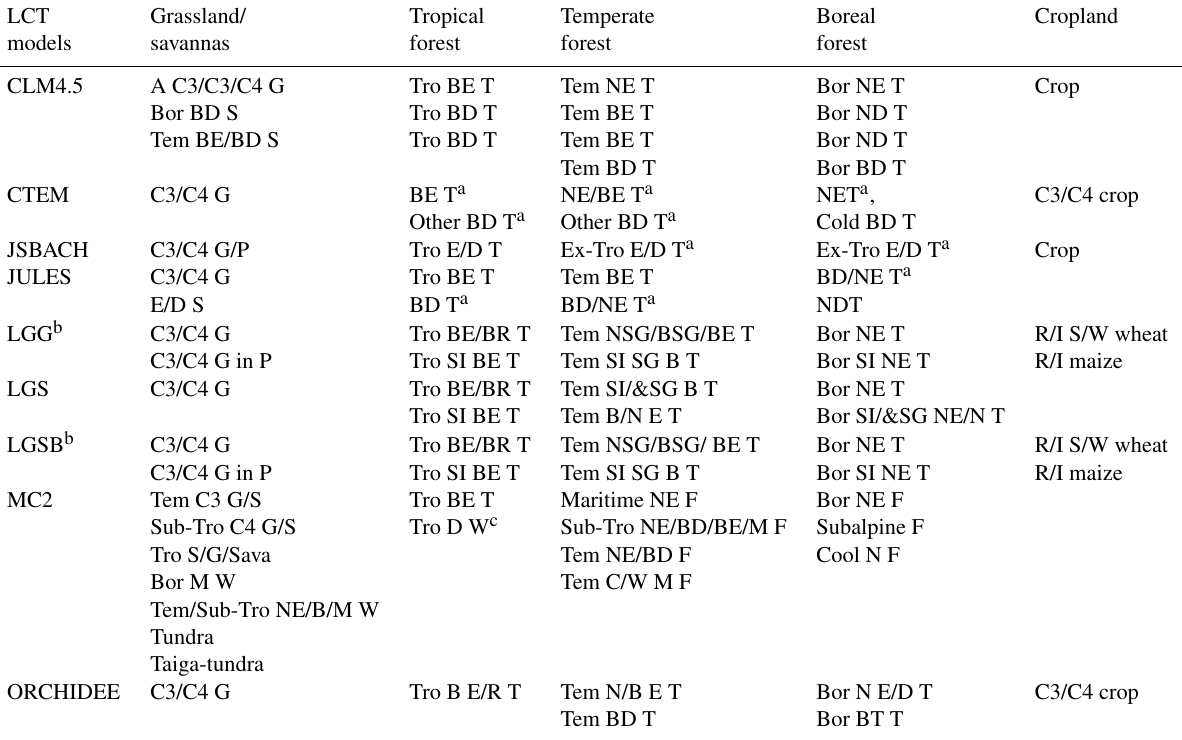
Table 4. Attribution of plant function types (PFTs) in FireMIP DGVMs to land cover types (LCTs) for emission factors described in Table 2. LCT Grassland/ models